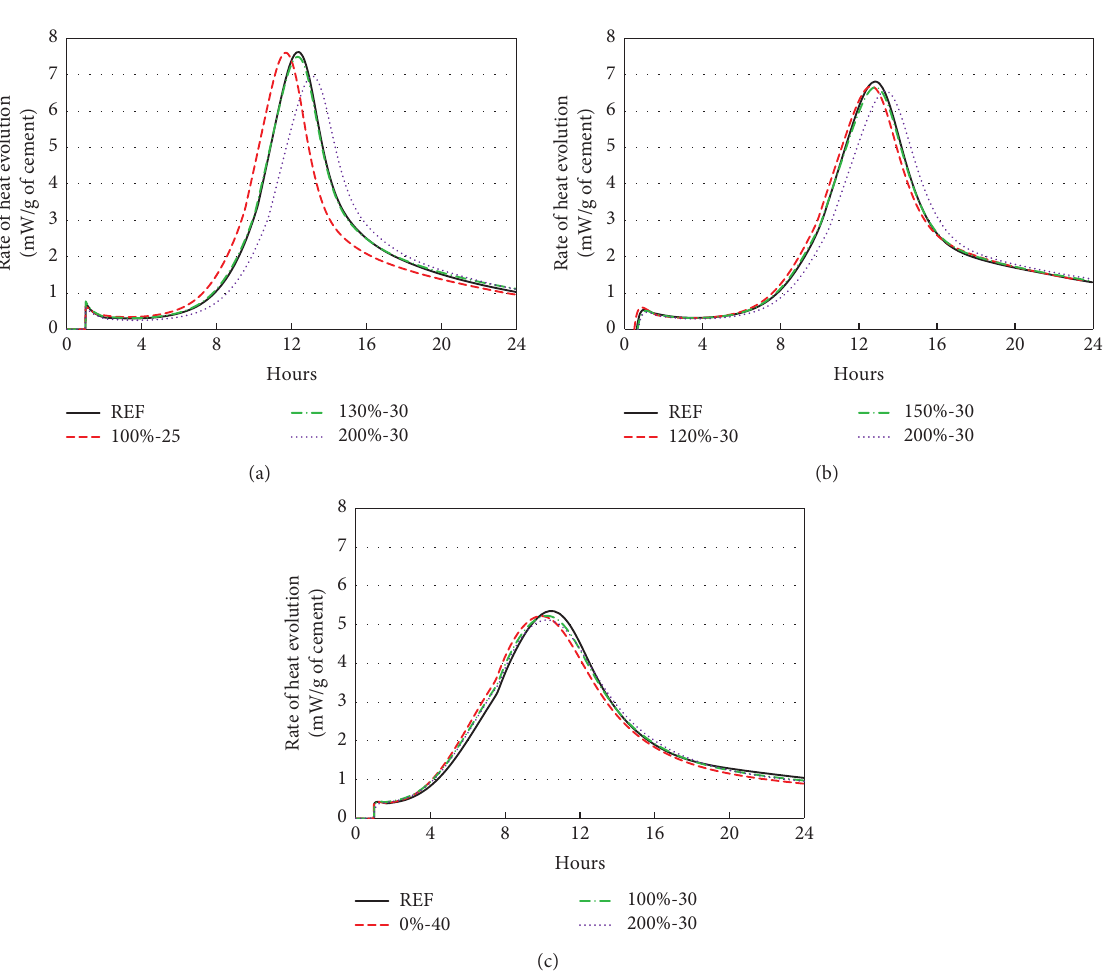
Figure 4: Rate of hydration curves of ACF-containing cement pastes: (a) w / c � 0.25 with 100%, 130%, and 200% additional water, (b) w / c � 0.30 with 120%, 150%, and 200% additional water, and (c) w / c � 0.40 with 0%, 100%, and 200% additional